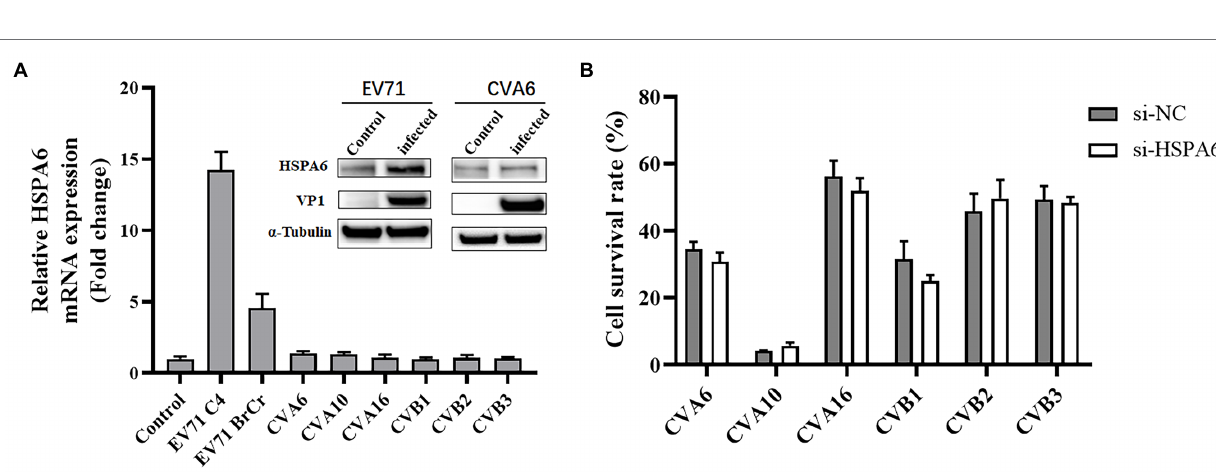
FIGURE 5 | EV71 infection enhances the cytoplasmic aggregation of HSPA6. (A) Confocal microscopy analysis of RD cells infected with EV71 at 8 hpi. (B) Confocal microscopy analysis of RD cells infected with EV71 at 24 hpi. Cells were stained with VP1/ Alexa Fluor 488, HSPA6/Alexa Fluor 594, and